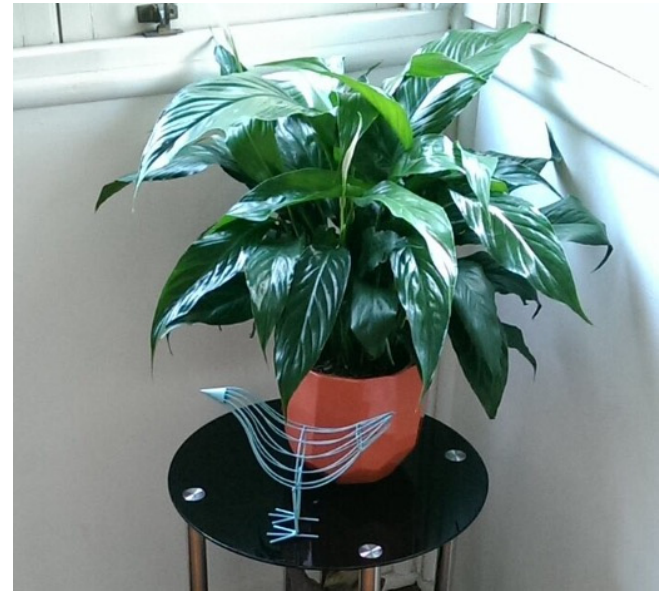
Figure 1. Symbiotic nurturing: Indoor plant to show nurturing of plants.